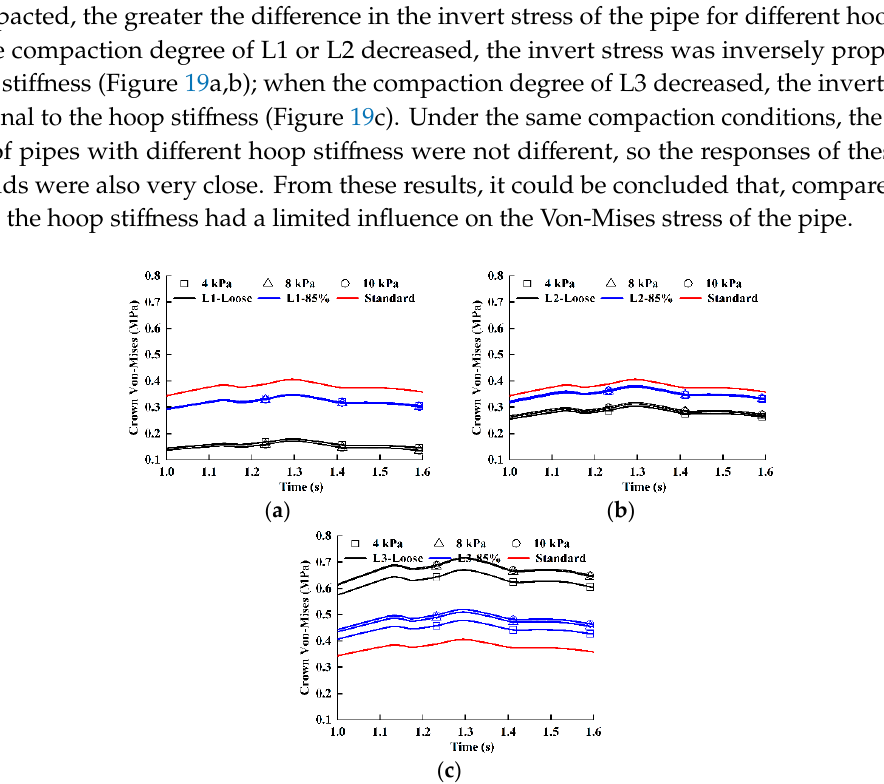
Figure 17. The crown Von-Mises stresses of pipes of different hoop stiffness under traffic load: ( a ) change in L1 compaction degree; ( b ) change in L2 compaction degree; ( c ) change in L3 compaction degree.